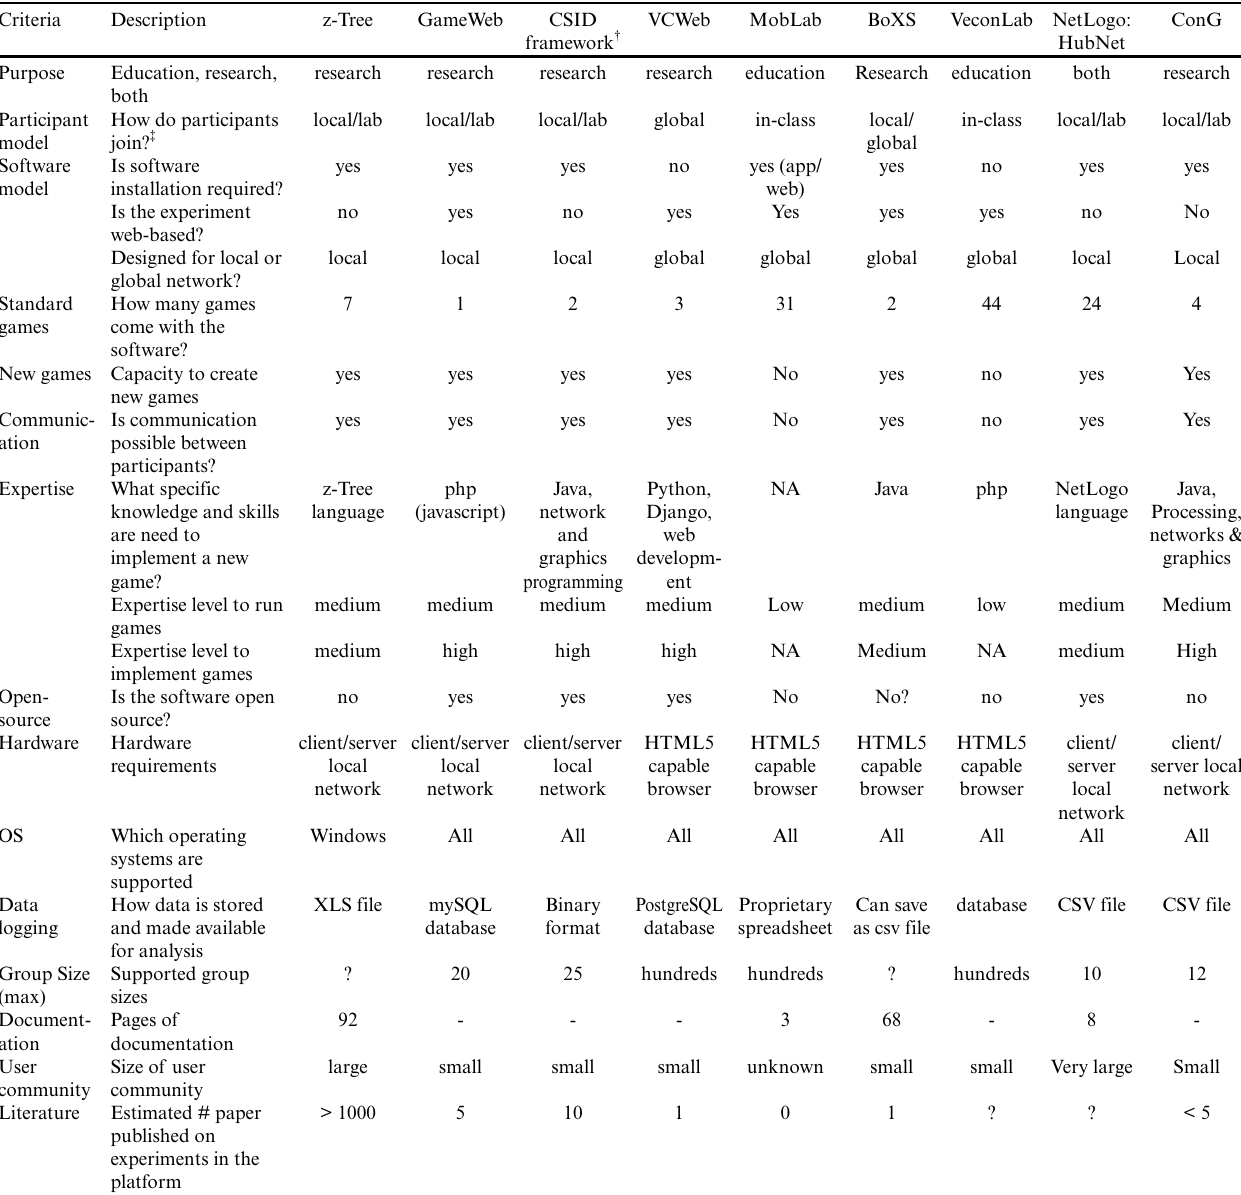
Table 1. Comparison of experimental platforms on diverse criteria based on available documentation and expertise with the various